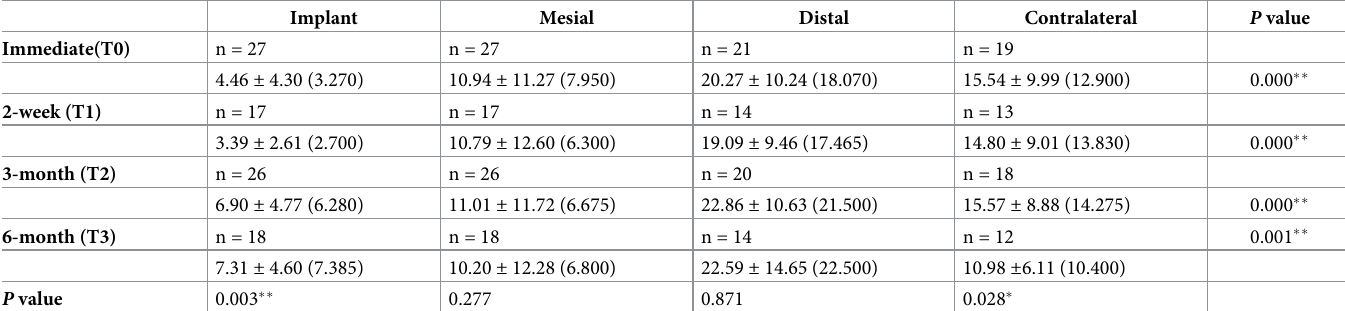
Table 7. Changes in the bite force distributed on implants and natural teeth with time (Group 2). Implant Mesial Distal Contralateral